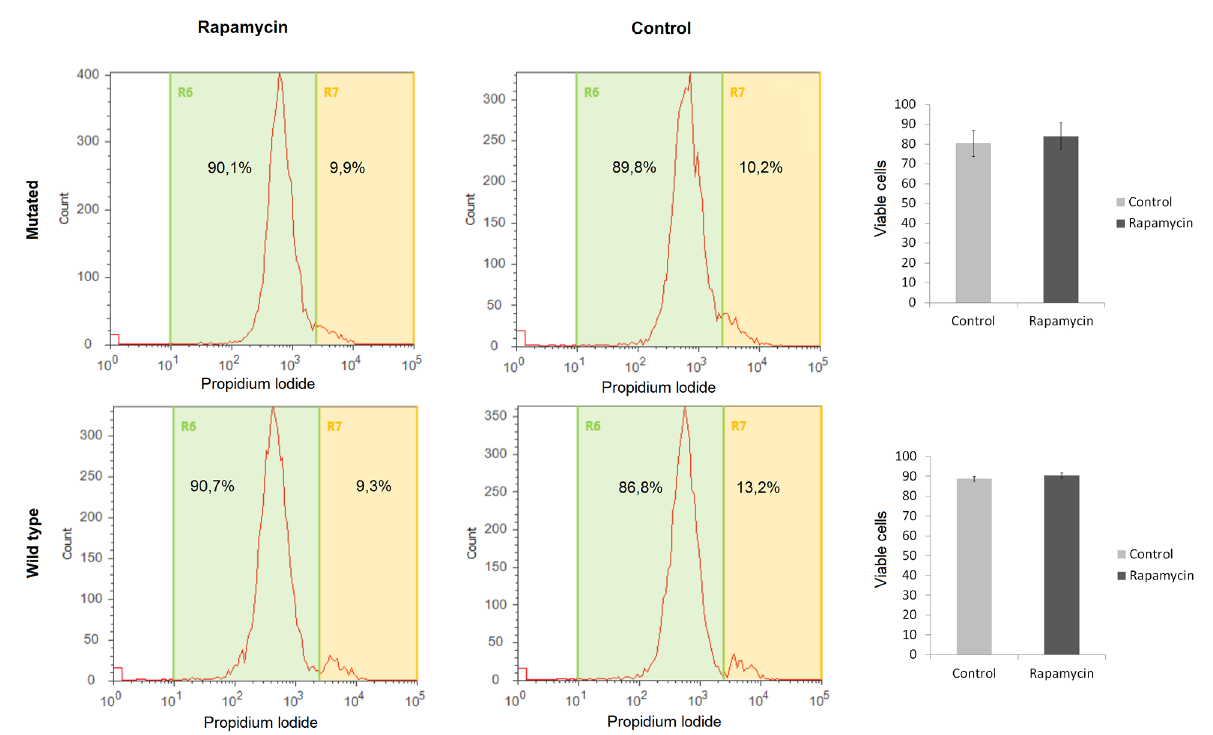
Figure 1 ‒ Cell viability analyses. Cells were stained with propidium iodide and submitted to Attune Cytometer analysis. Viable cells (%) of a representative mutated and WT samples are shown in the left panel. The average percentage of viable cells in mutated and wild-type groups is shown in the right